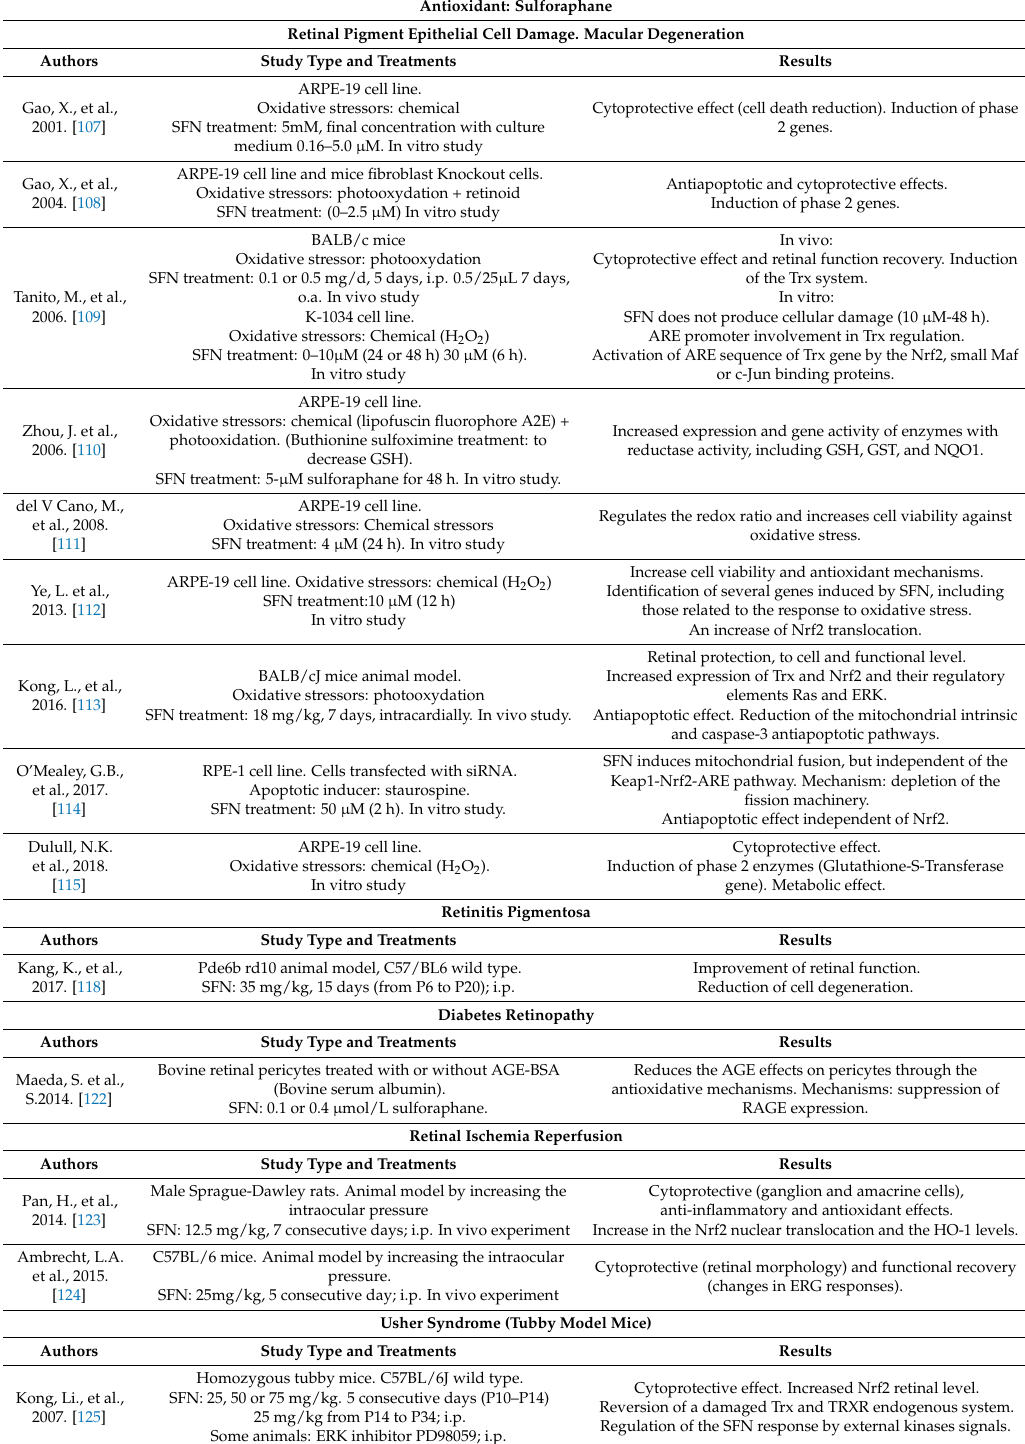
Table 3. Antioxidant effects on experimental pathology retinal models. Antioxidant: